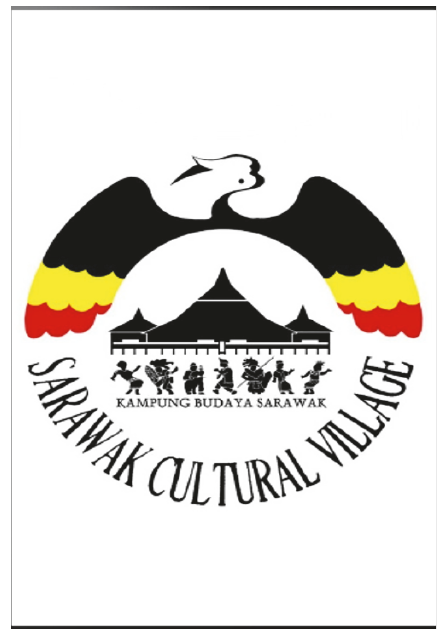
Figure 5: Mobile guide flash screen.